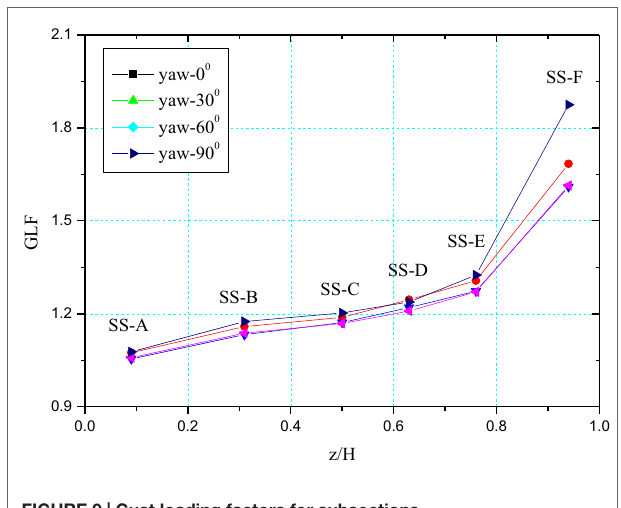
FigUre 9 | gust loading factors for subsections